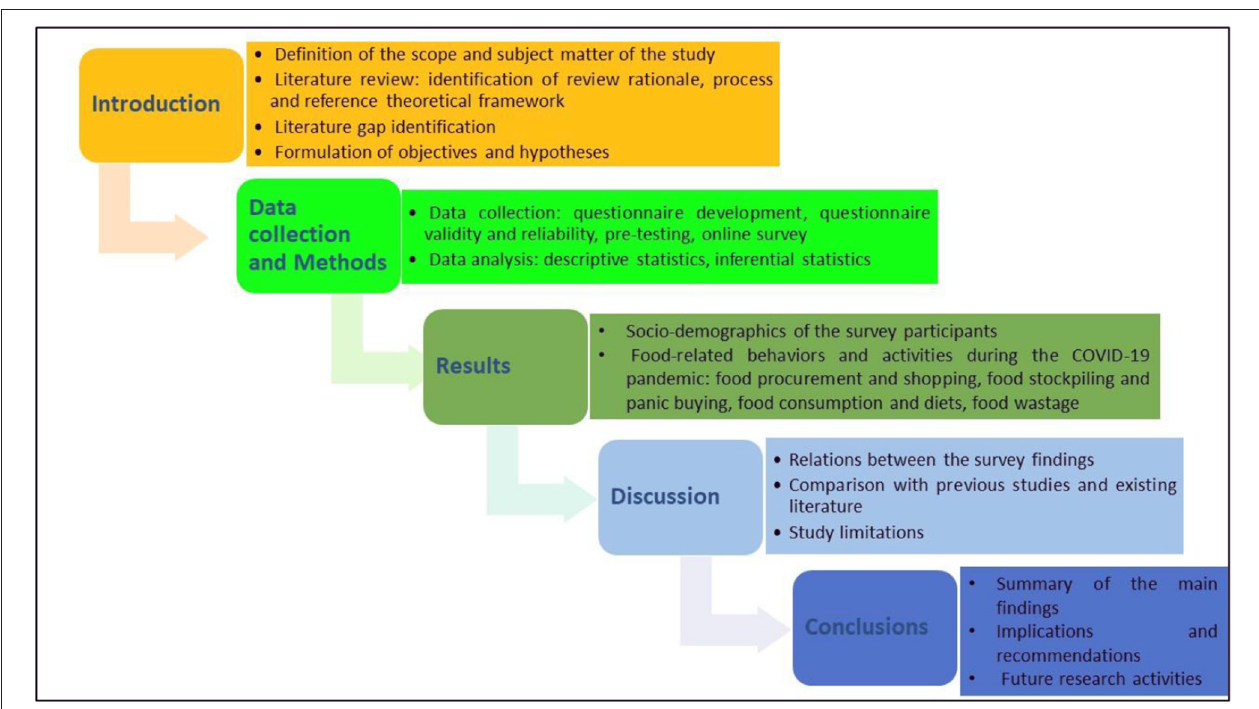
FIGURE 1 | Research